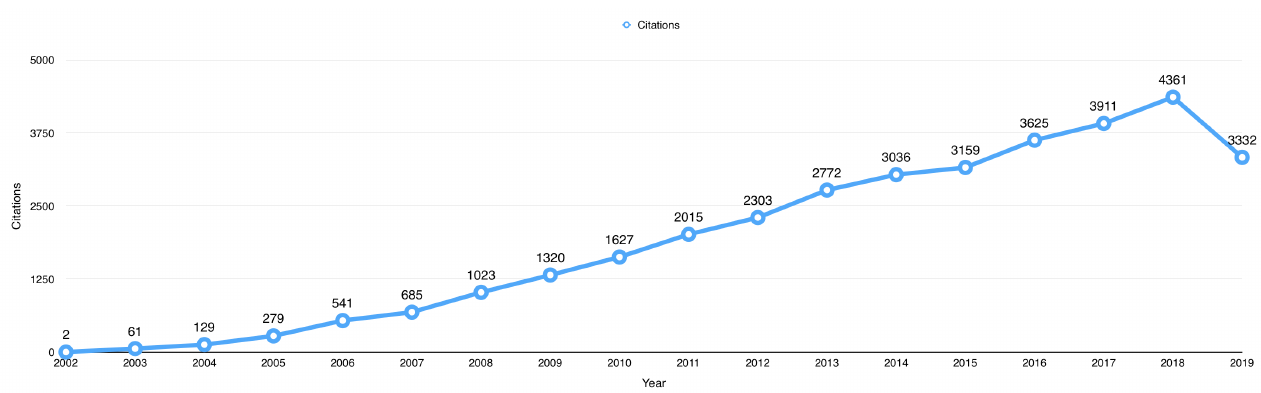
Figure 3. The total number of citations received by open data publications per year.